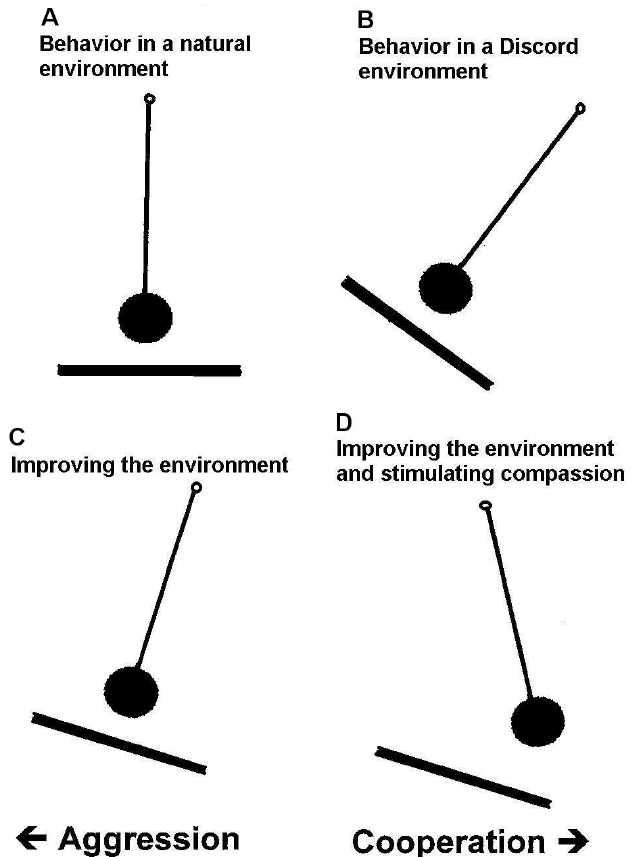
FIGURE 1 . The pendulum as an analogy to aggressive vs. cooperative behavior. In the natural environment, the pendulum will follow the pull of gravity (A). More aggressive behavior is a likely consequence of a stressful, discord environment (B). It is possible to improve cooperation either by creating an environment with less discord (C) or by actively pulling the pendulum towards geniality